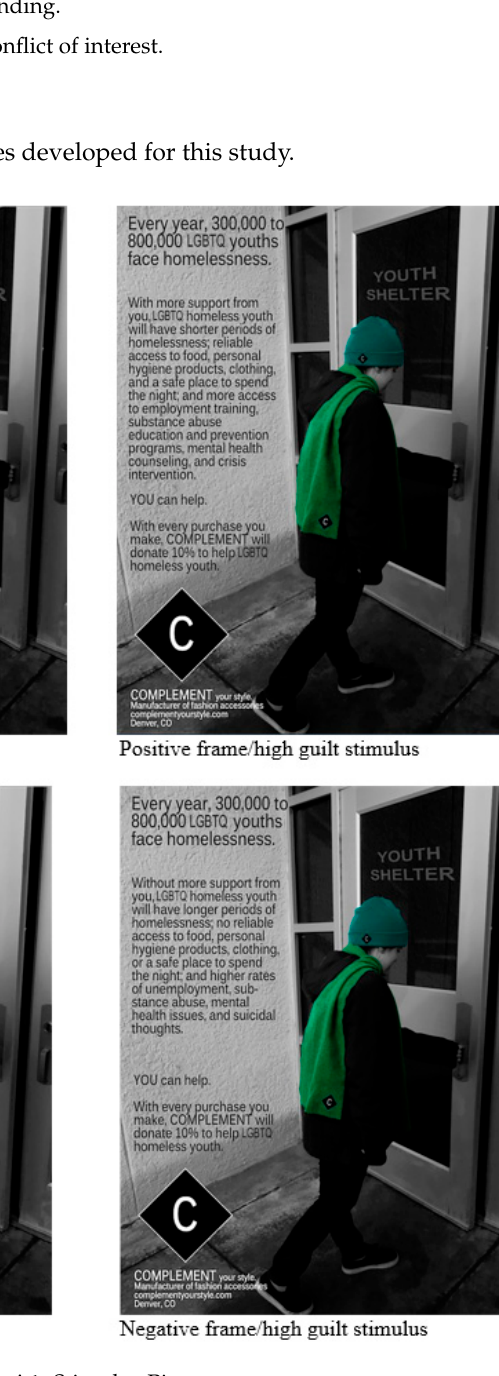
Figure A1. Stimulus Pictures.